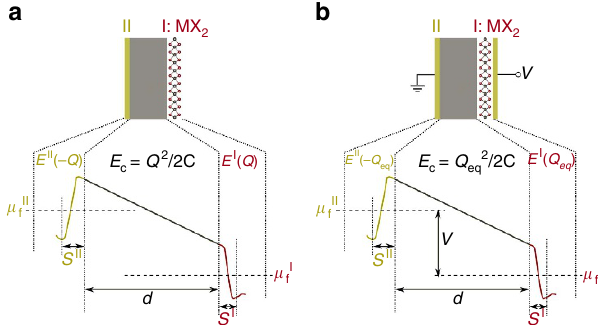
Figure 2 | Energy calculations for systems containing a charged monolayer. Layer I is a monolayer TMDs with a Fermi level m f I , and plate II has a Fermi level of m f II . Charge Q on the monolayer TMDs is fixed in a , whereas the voltage V is fixed in b giving rise to an equilibrium charge Q eq . A dielectric medium of thickness d and capacitance C , which can be vacuum, is sandwiched between the monolayer and the plate. Distance s I is the separation between the centre of the monolayer and the right surface of the dielectric medium, and s II is the separation between the surface atoms of plate II and left surface of the dielectric medium. The total energy in the fixed charge case is the sum of three parts: energy stored in the dielectric medium E c , energy of the plate II E II , and energy of the charged monolayer monolayer TMDs E I . NATURE COMMUNICATIONS|7:10671|DOI: